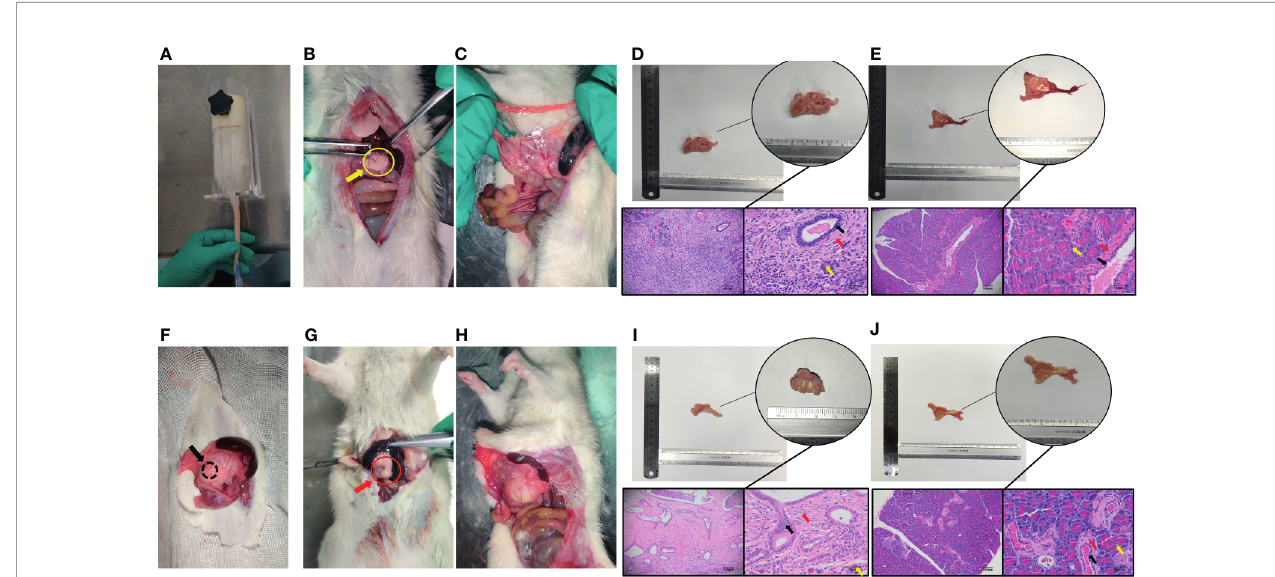
FIGURE 4 | Establishment and identi fi cation of CP and PDAC model rats. (A) The rat CP models were established by injecting DBTC solution through the tail vein; (B, C) After 6 weeks of modelling, the pancreas of rats in the CP group and the pancreas of rats in the control group (injection of saline) were collected. Severe fi brosis was observed in the pancreas - yellow arrow of the CP group; (F) Rats with orthotopic pancreatic cancer induced by surgical implantation of DMBA; (G, H) : Sixteen weeks after modelling, the pancreas of rats in situ PDAC and the pancreas of rats in the sham operation control group. Severe fi brosis and local mass formation were observed at the pancreatic red arrow of the rats in the in situ PDAC group; (D, E) Gross pancreatic specimens and pathological HE staining of rats in the CP group and control group (100X and 400X; black arrow: normal epithelial duct cells; red arrow: stromal cells ( fi broblasts, PSCs); yellow arrow: acinar cells); (I, J) Gross pancreatic specimens and pathological HE staining of rats in the in situ PDAC group and control group (100X and 400X; black arrow: cancer/ normal epithelial duct cells; red arrow: stromal cells ( fi broblasts, PSCs); yellow arrow: acinar cells).